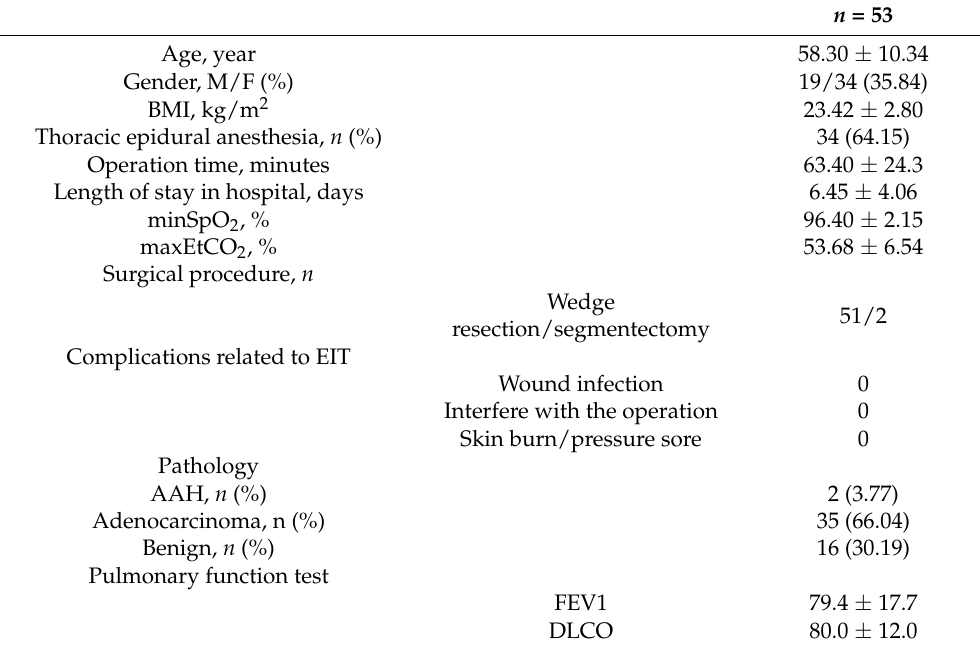
Table 1. Characteristics of the patients undergoing NITS with